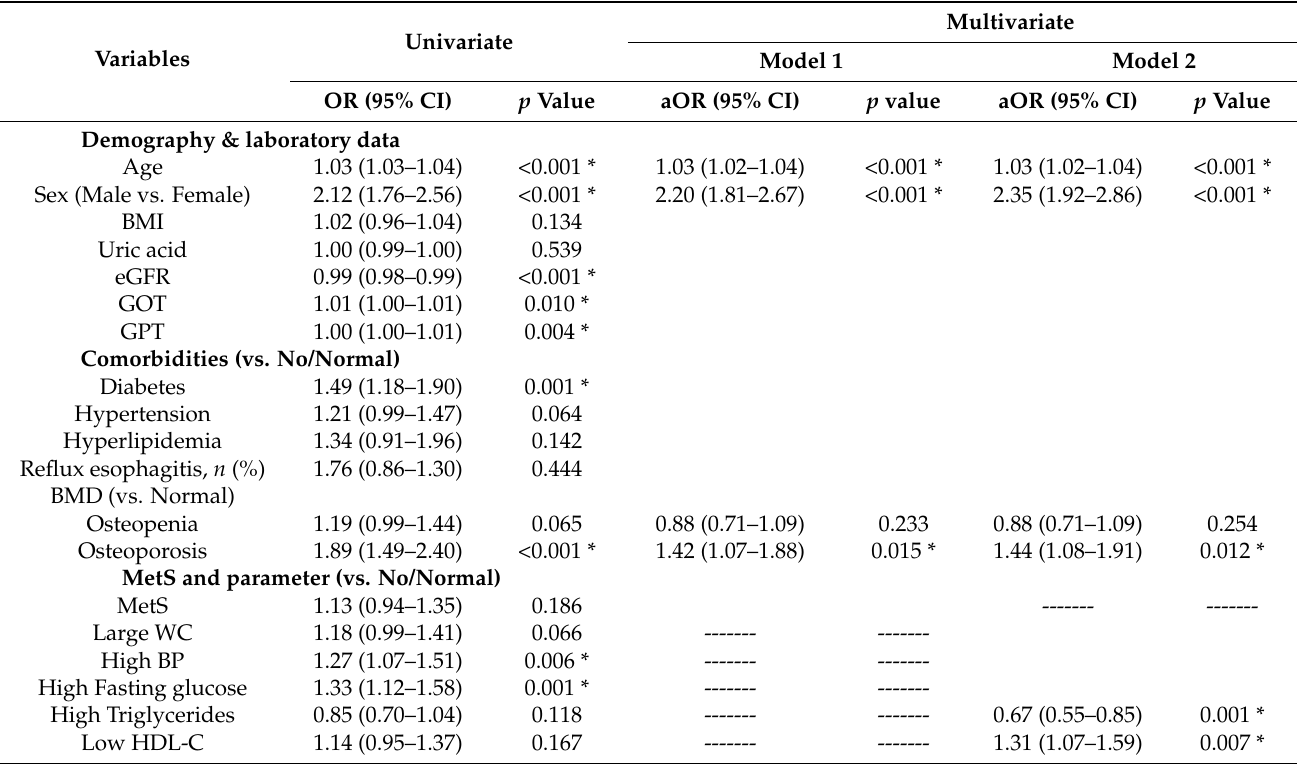
Table 4. Risk factors for duodenal ulcer